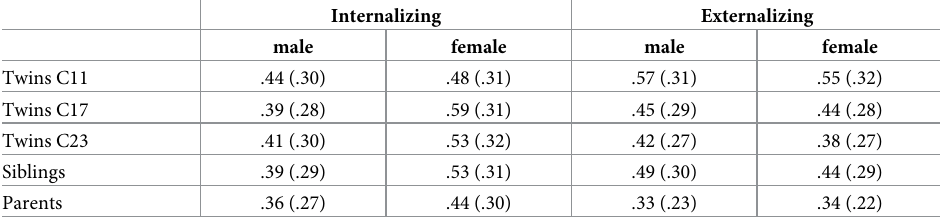
Table 2. Descriptive statistics for internalizing and externalizing.